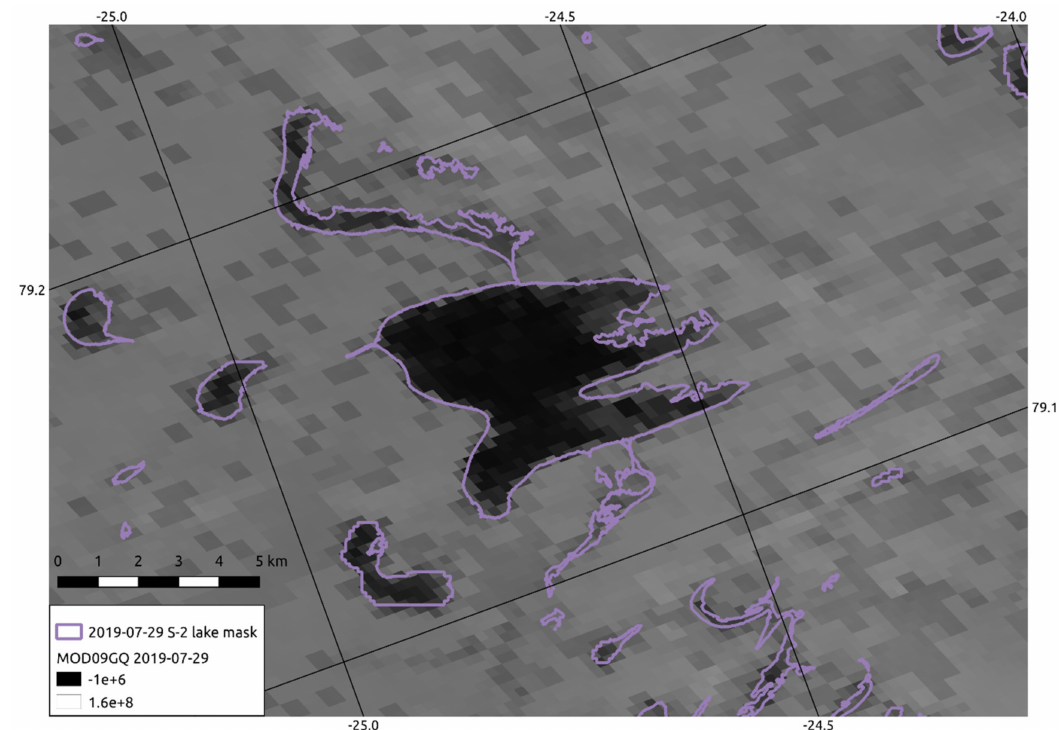
Figure A3. Influence of pixel size on lake detection: contours of the largest detected lake using Sentinel-2 on 29 July 2019, against MODIS band 1 reflectance of the same day (MOD09GQ, 250 m resolution).